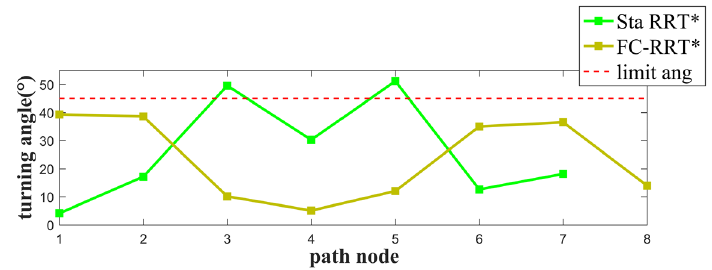
Figure 11. The turning angle comparison between FC-RRT* and RRT*.